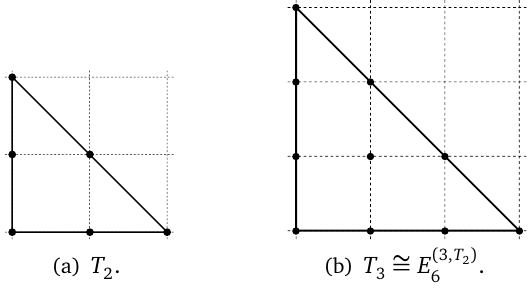
. toric geometry. They have 3